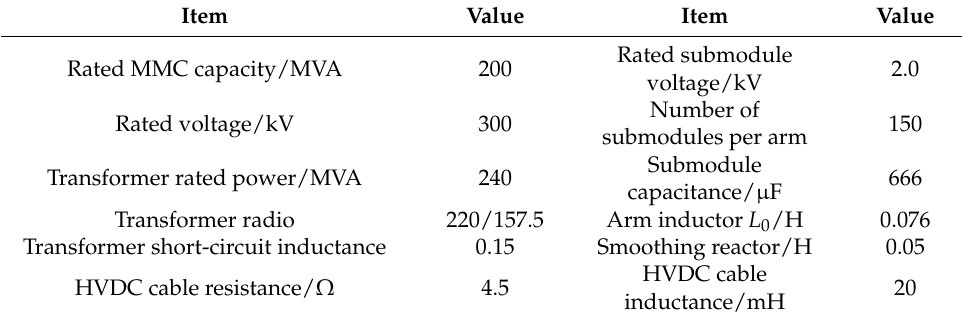
Table 4. Parameters of the onshore converter and HVDC cable.